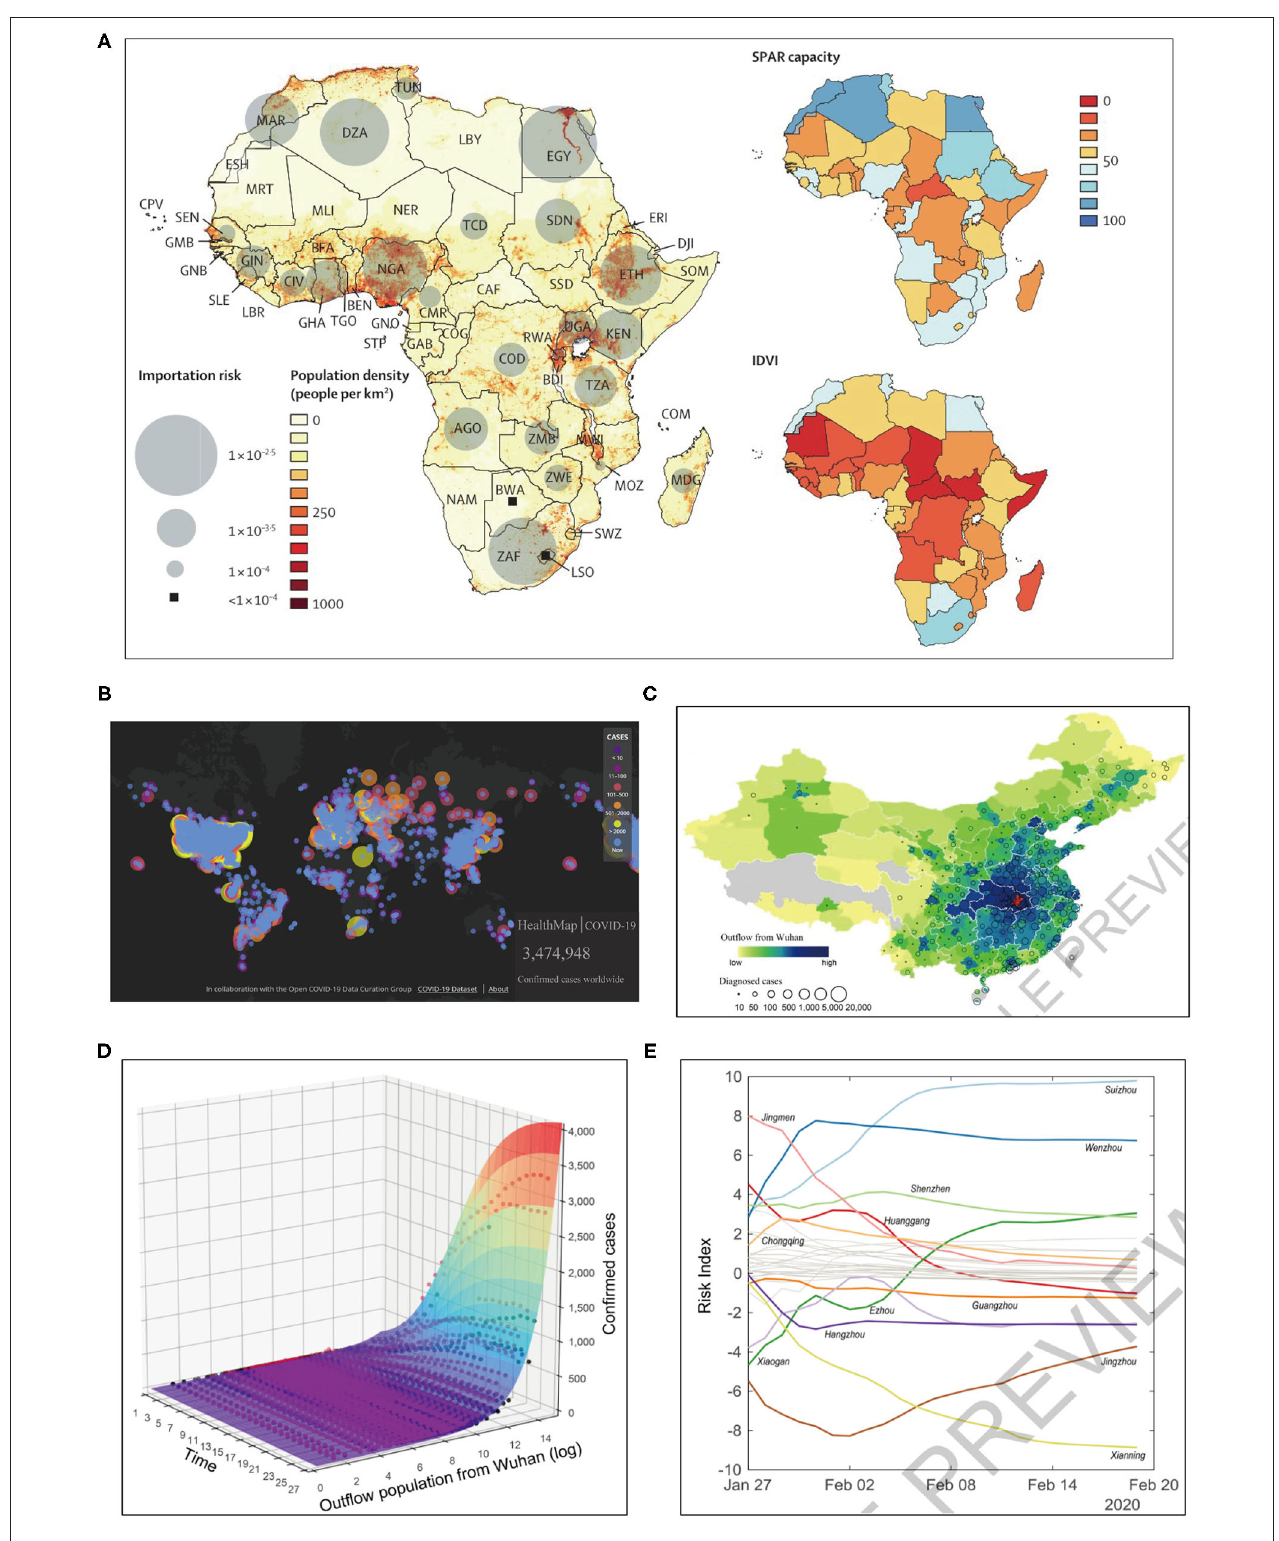
FIGURE 3 | Telemedicine based on artificial intelligence and big data technologies for the surveillance of COVID-19 pandemic. (A) Big data based modeling study: preparedness and vulnerability of African countries against importations of COVID-19 (35). (B) Online contagious COVID-19 surveillance mapping provided